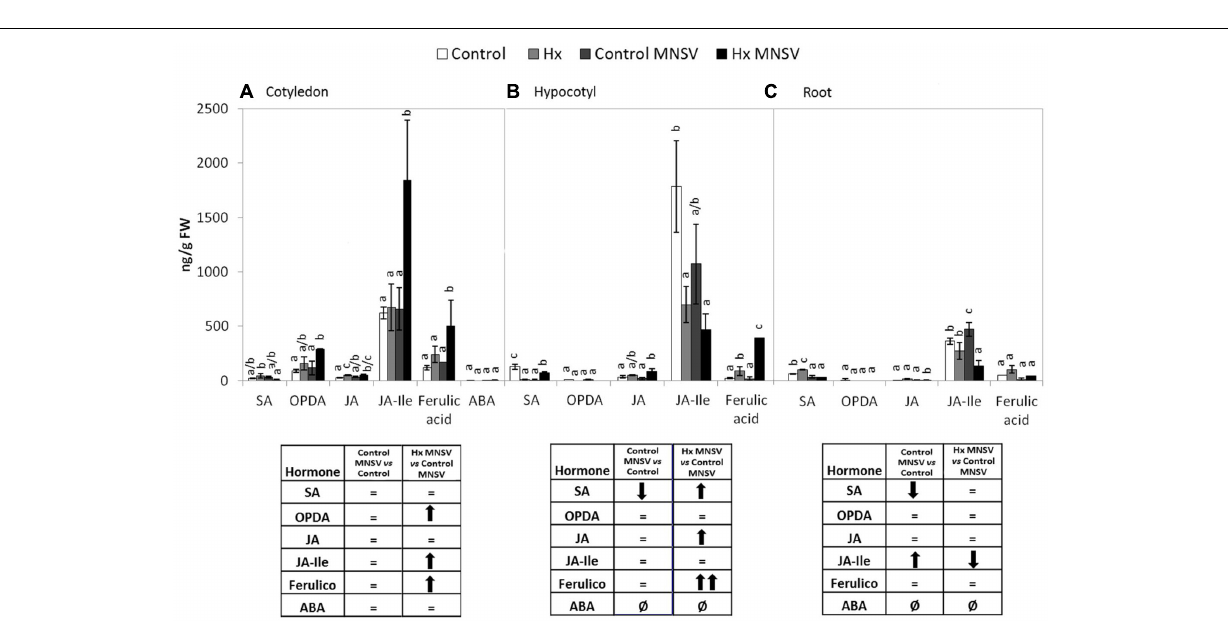
FIGURE 5 | Metabolic profile in the control and Hx-treated plants upon MNSV infection in early infection stages. Plants were grown and inoculated as described in Figure 2C . Different tissues were collected at 24 hpi, and the SA, OPDA, JA, JA-Ile, ferulic acid, and ABA levels were determined by UPLC–MS. (A) Cotyledon, (B) hypocotyl and (C) root metabolic profiles. Significant changes are symbolized in a table below the graph: (=) no significant differences; ( ↑ , ↓ ) statistically significant increase or decrease; and ( ↑↑ , ↓↓ ) statistically significant twofold increase or decrease. Data represent the mean ± SE of three independent experiments with 10 plants per experiment. Letters indicate statistically significant differences for each hormone ( p < 0.05; least significant difference